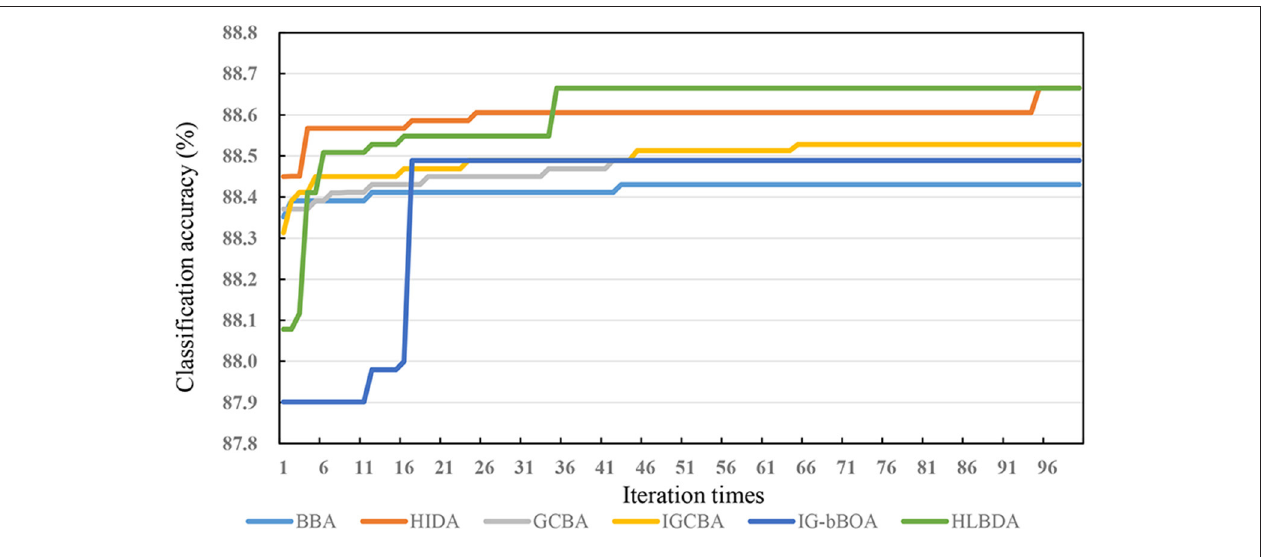
FIGURE 2 | Convergence curves of the six algorithms on the survey